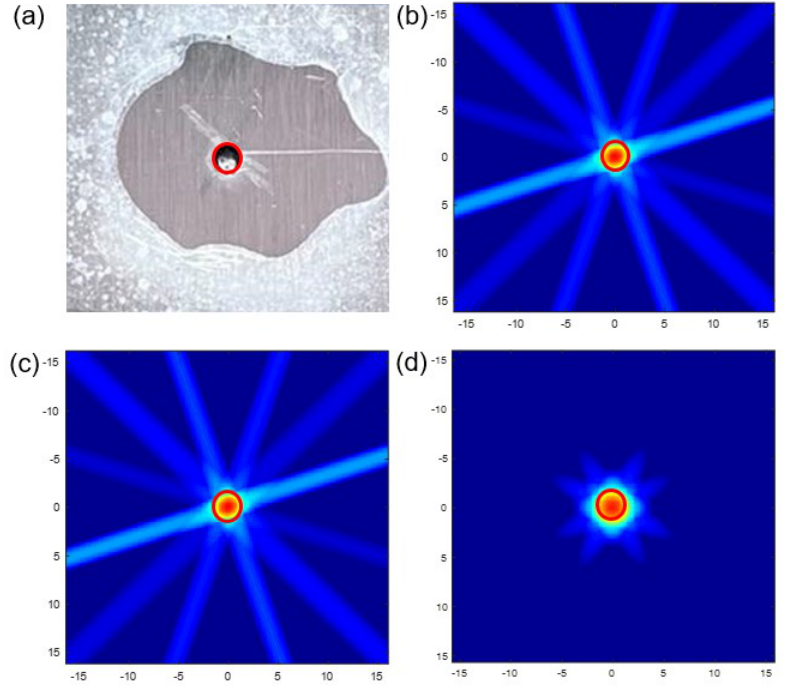
Figure 7. Enlarged view of real defect and simulated damage: ( a ) real defect. ( b ) SDC. ( c ) RMSE. ( d ) E